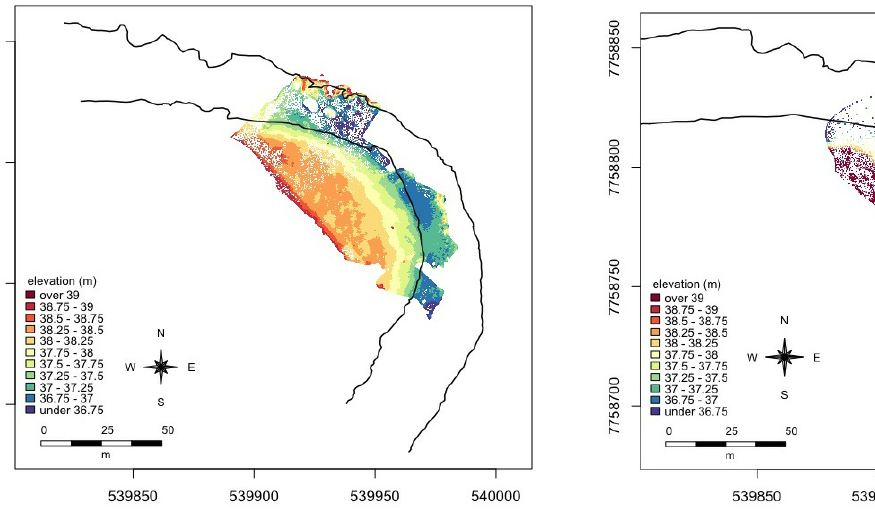
UAV photogrammetry-derived point cloud of 2010 ( left ) and 2011 ( right ) coloured by